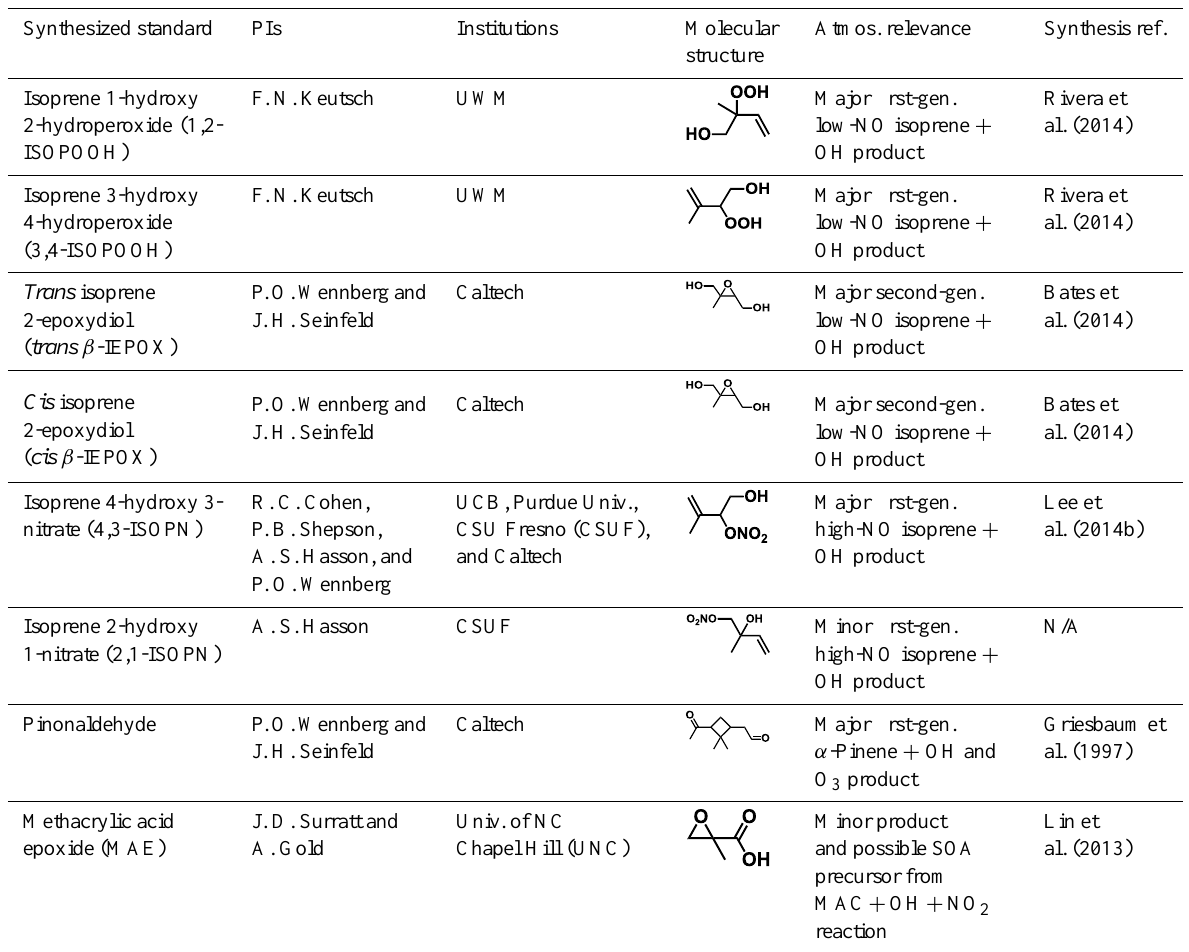
Table 3: List of contributed synthesized chemical standards for experiments and calibration. 1 Synthesized standard PIs